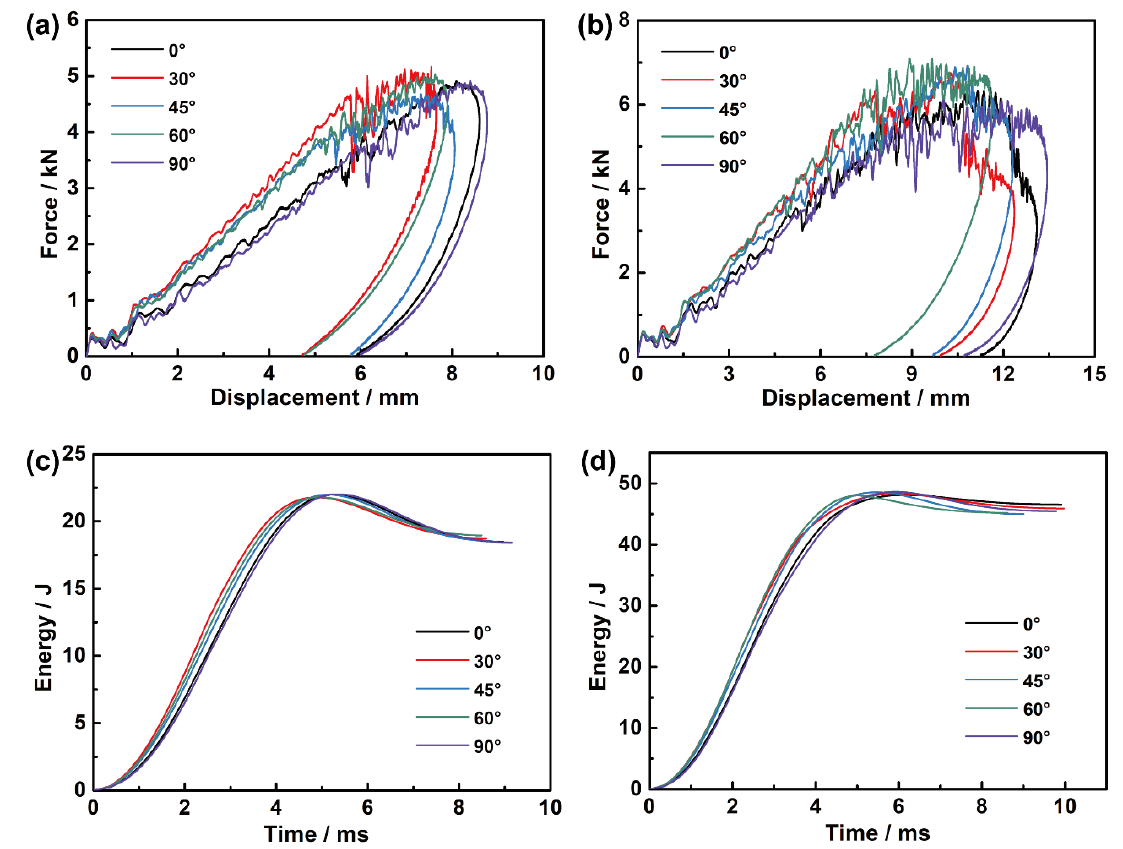
Figure 4. Impact responses: ( a ) force-displacement curves under 21.6 J of impact energy; ( b ) force- displacement curves under 47.6 J of impact energy; ( c ) energy-time curves under 21.6 J of impact energy; ( d ) energy-time curves under 47.6 J of impact energy.